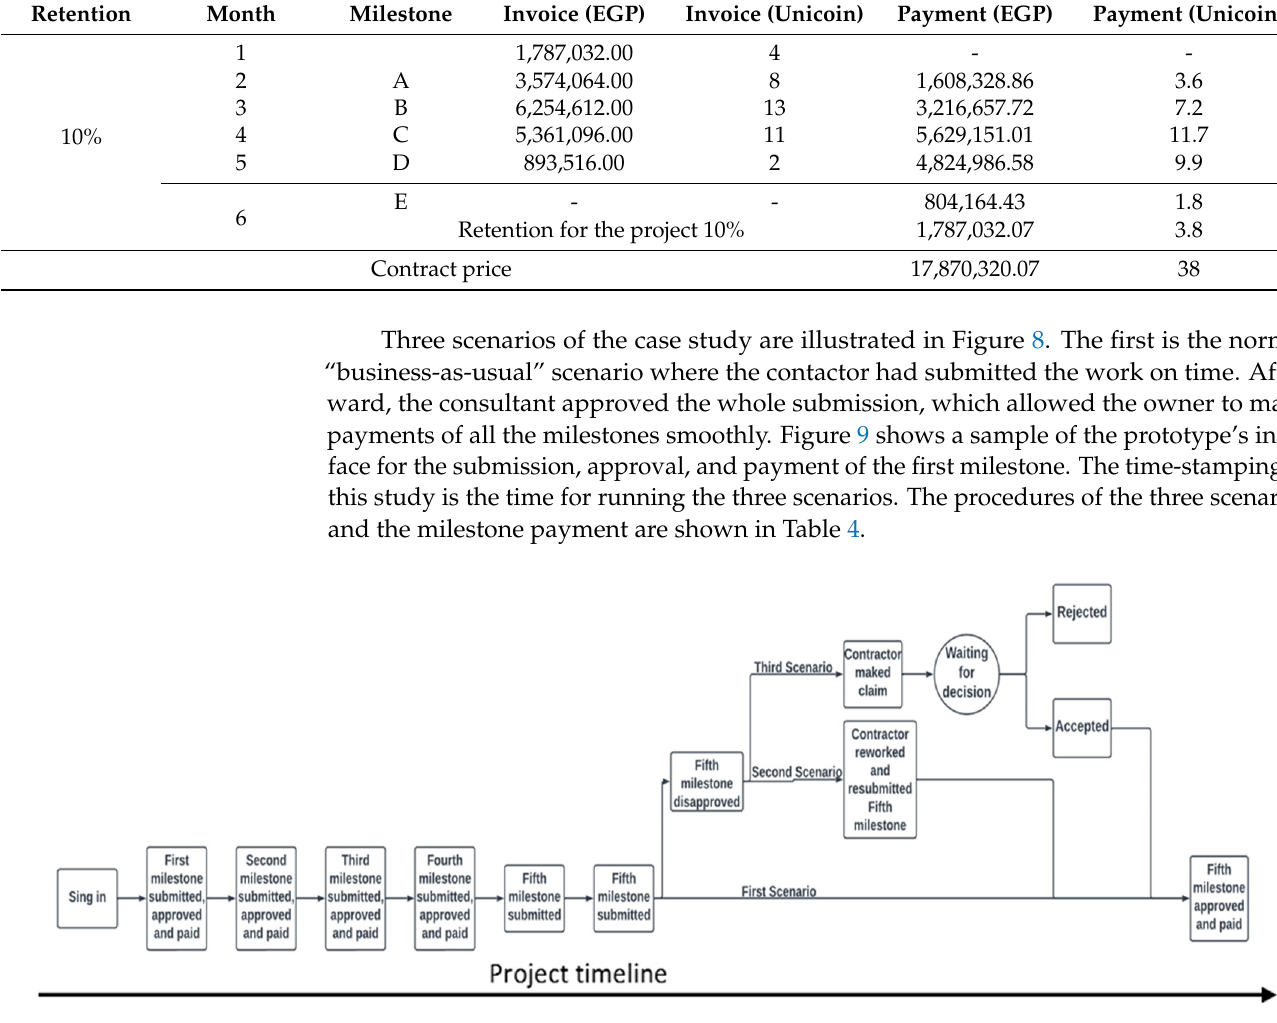
Figure 8. The three scenarios of the hypothetical case study.